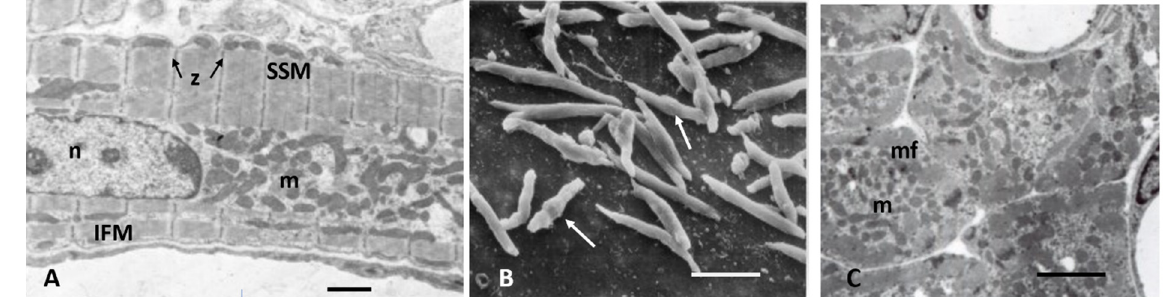
Figure 2. Neonatal rat. ( A ) Electron micrograph of P8 rat. Lateral sub-sarcolemmal myofibrils aligned between Z-bands (z), mitochondria (m) adjacent to the nucleus, intermyofibrillar (IFM), and subsarcolemmal (SSM). Bar = 2 µm. ( B ) Scanning electron micrograph of P3 rat isolated cardiomyocytes; note spindle shape and central nuclear bulge (arrows); Bar = 20 µm. ( C ) Electron micrograph of cross-section cardiomyocytes of P6 dog. Note peripheral myofibrils (mf), central mitochondria (m). Bar = 2 µm.